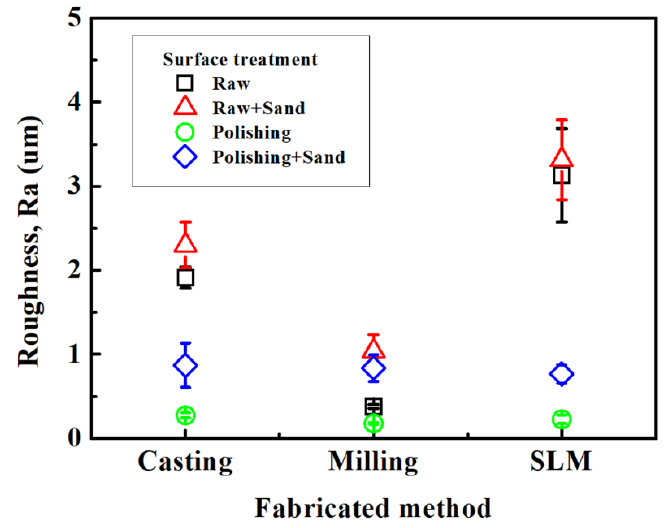
Figure 6. Mean ± SD surface roughness values (Ra) following different manufacturing techniques.